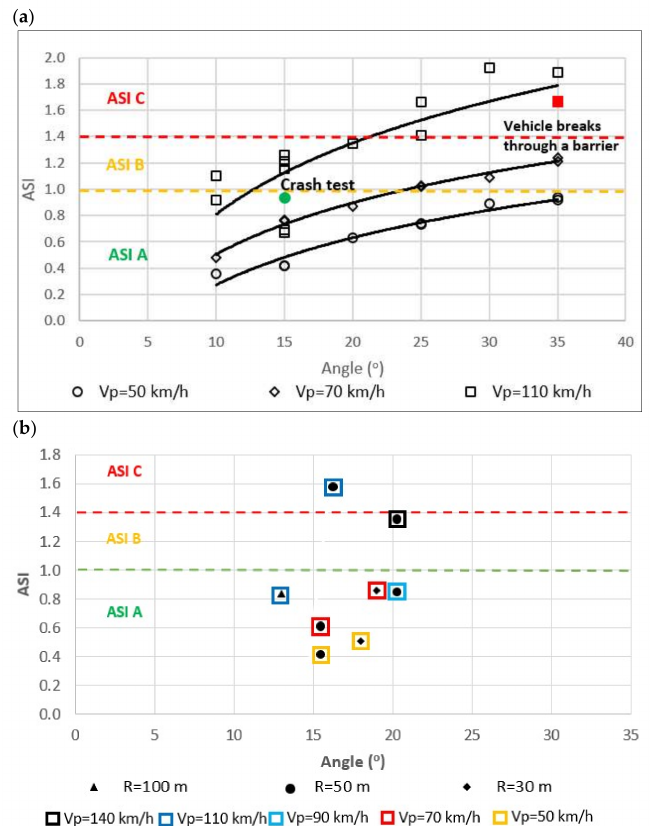
Figure 14. ASI rates achieved in numerical simulations of a vehicle impacting: ( a ) the SE’s beam, ( b ) a safety barrier behind an